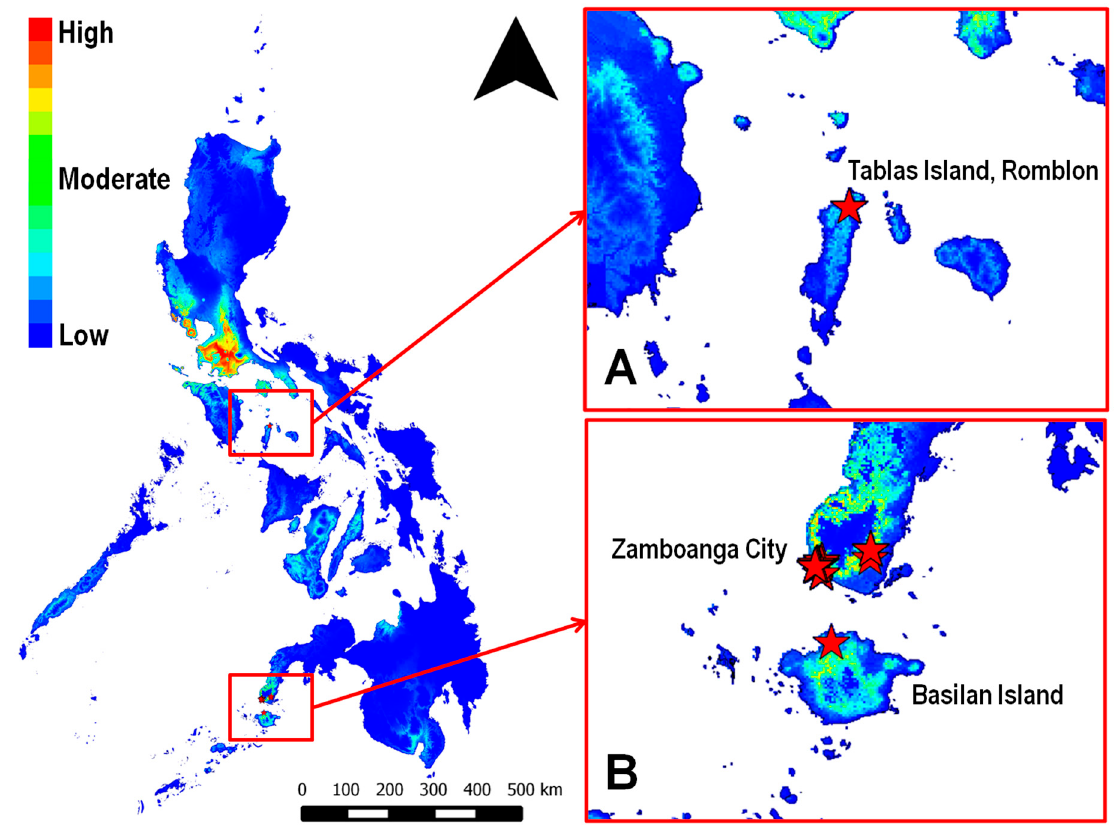
Figure 3. Maxent SDM of Comperiella calauanica , with areas in Romblon ( A ) and Western Mindanao ( B ) where infestations of Aspidiotus rigidus had been confirmed. Red stars mark the points where confirmatory surveys were conducted between November 2016 and January 2017.